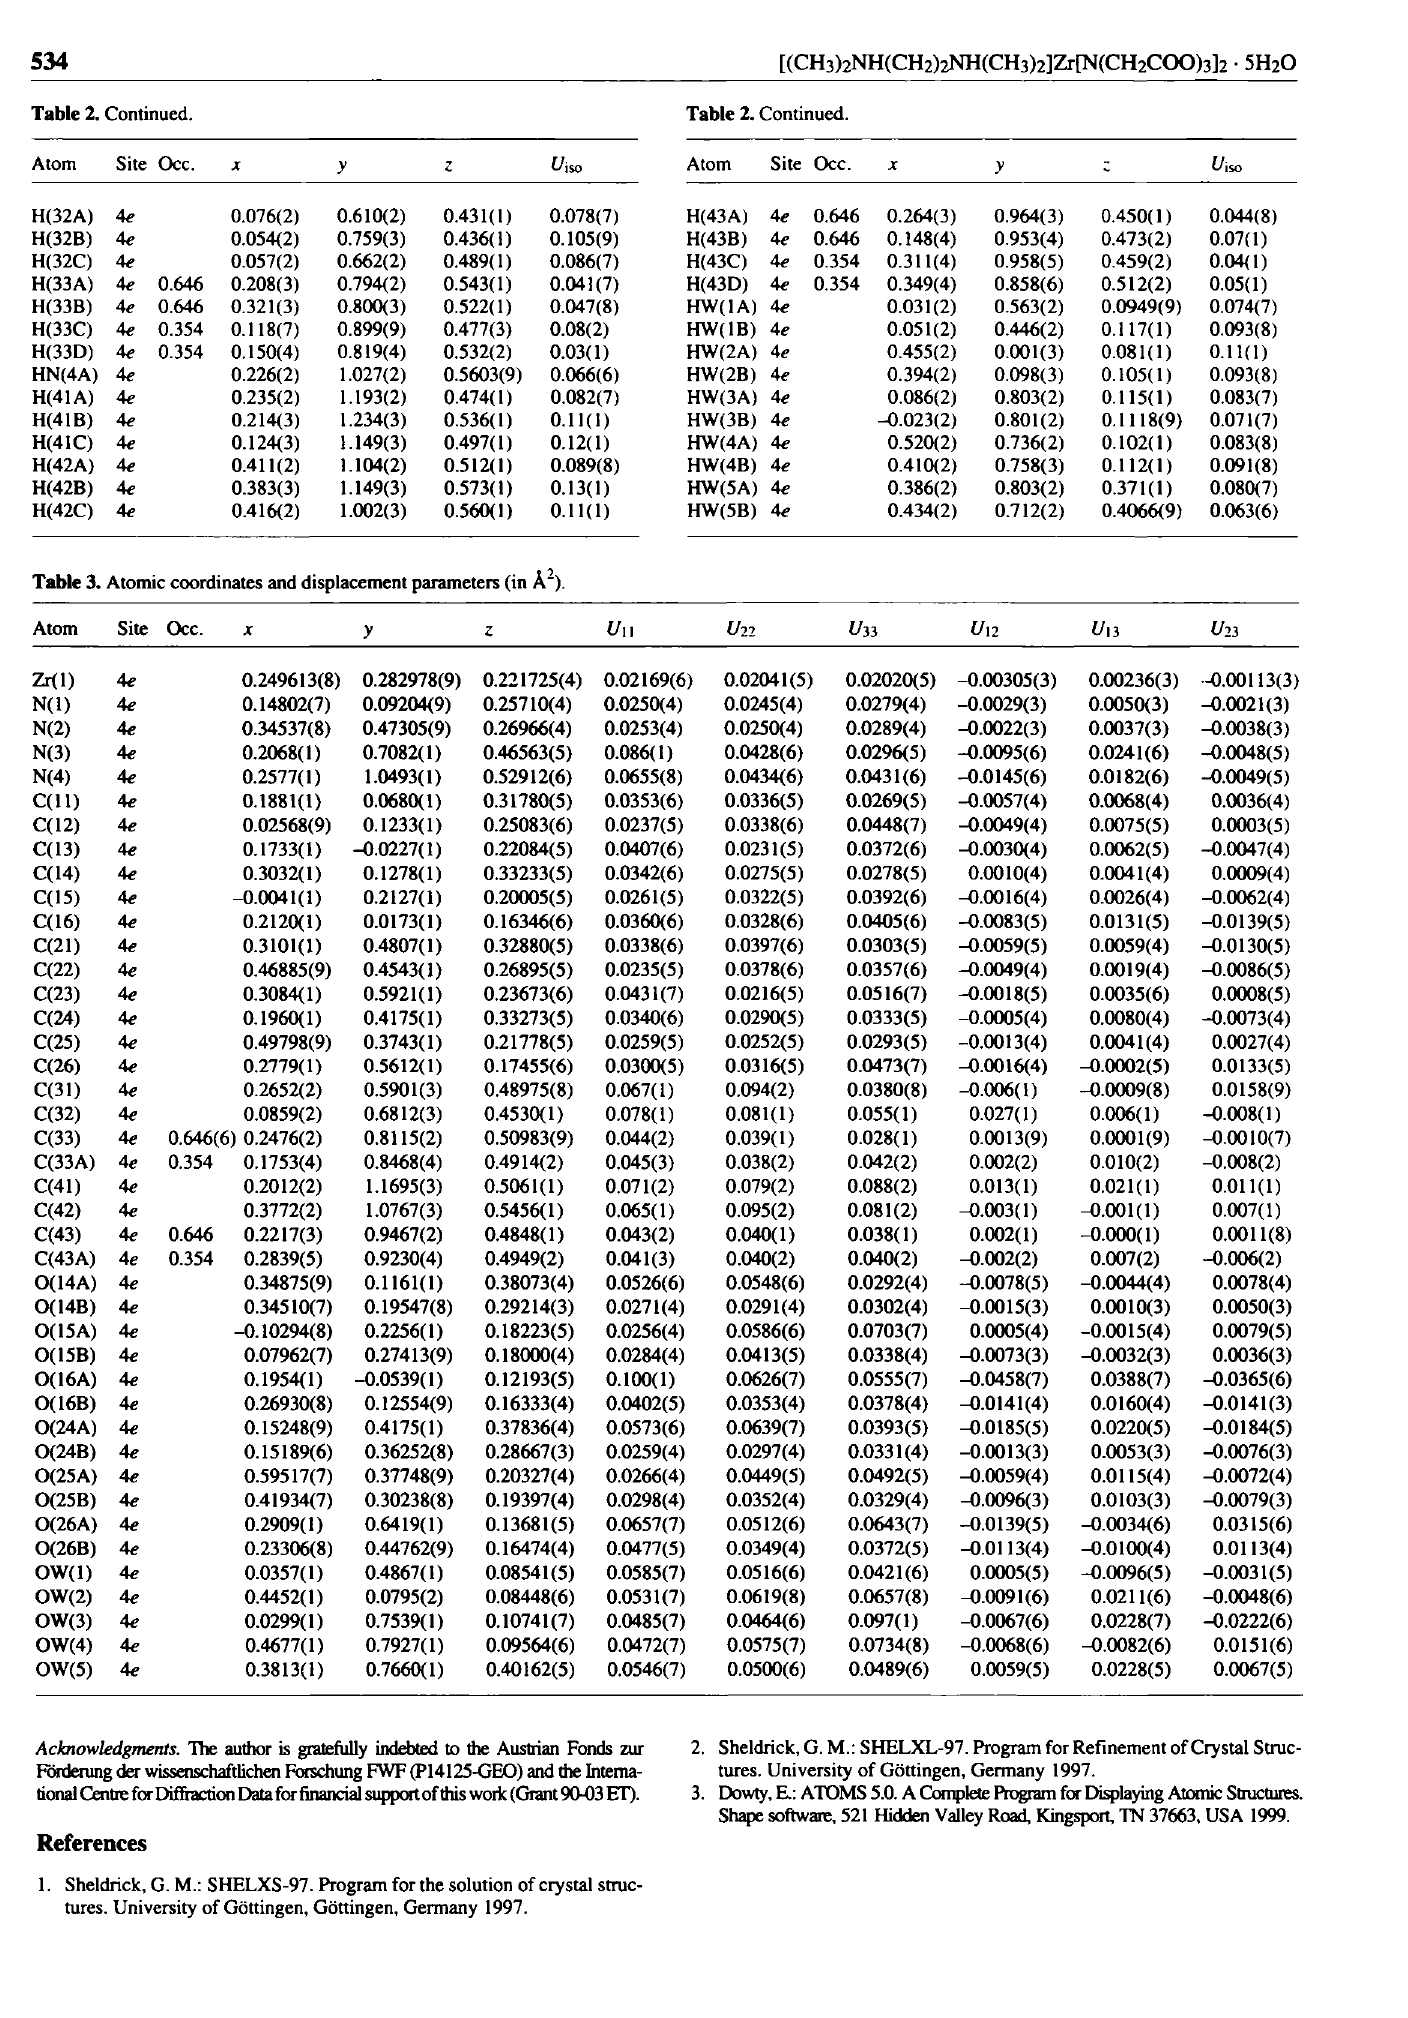
Table 3. Atomic coordinates and displacement parameters (in Â 2